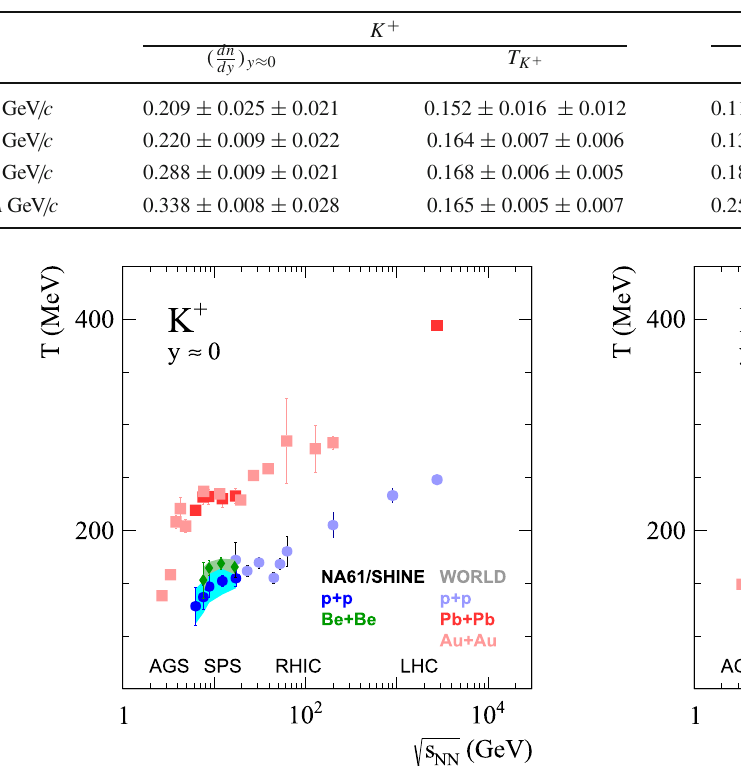
Table 3 Mid-rapidity K + and K − multiplicities dn / dy and inverse